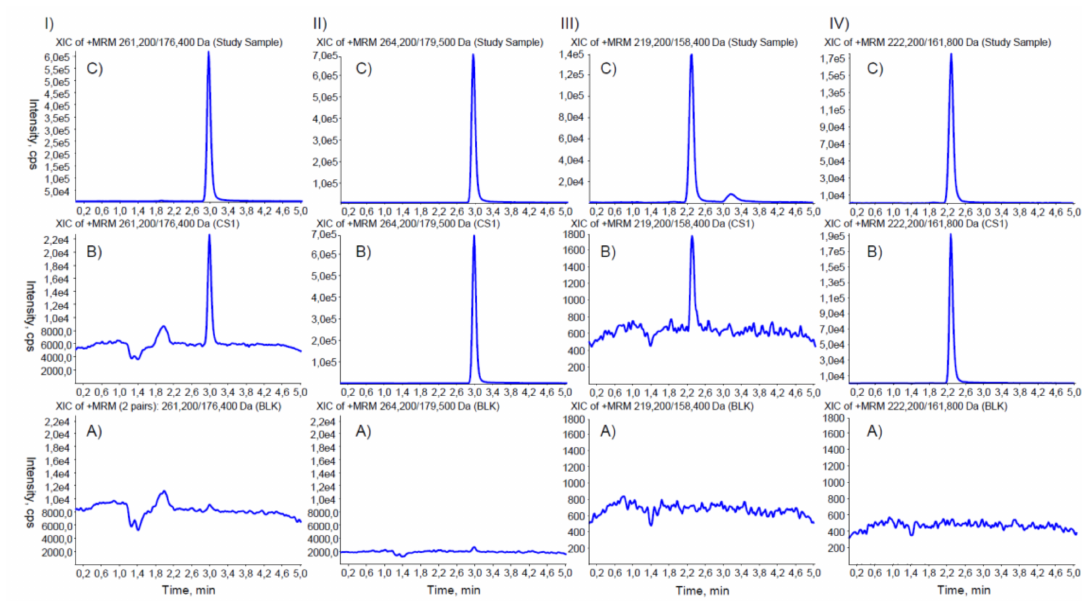
Figure A1. MRM chromatograms of carisoprodol ( I ) and I.S. ( II ), and meprobamate ( III ) and I.S. ( IV ), obtained from human plasma samples: ( A ) blank plasma, ( B) blank plasma spiked at the LLOQ level, and ( C ) plasma sample from a subject after treatment with 350 mg of carisoprodol (1.0 h after dosing, determined concentration of 929.5 and 1365.1 ng/mL for carisoprodol